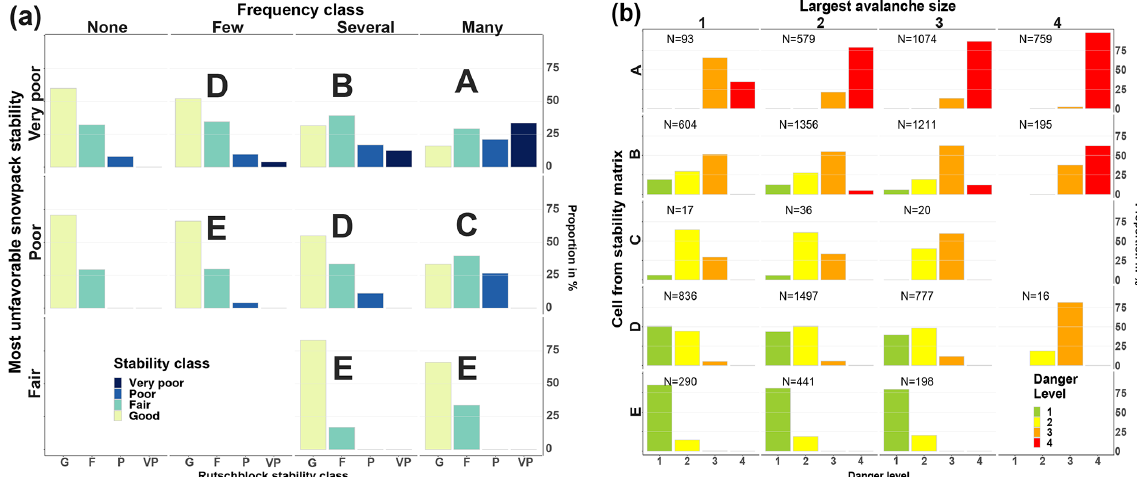
Figure 7. Data behind the matrices shown in Fig. 6. The layout of the columns and rows is identical to Fig. 6. The left panel (a) shows the mean simulated stability distributions behind the stability matrix (Fig. 6a). Letters describe cells with the corresponding most frequent and second-most-frequent danger level. In the right panel (b) , the distribution of danger levels for combinations of the typical largest avalanche size and the letters obtained before in the stability matrix (A–E, Fig. 6a) are shown. The most frequent and second-most-frequent danger levels in each cell–avalanche size combination are shown in the danger matrix in the right part of Fig.